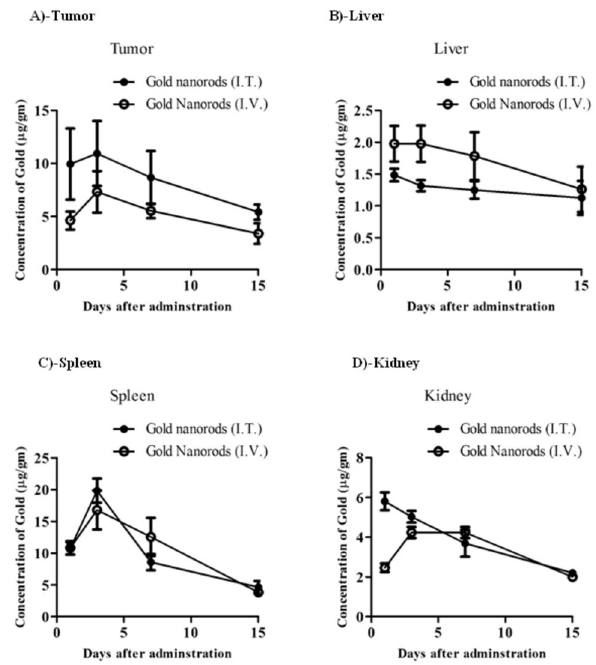
Figure 4. Tissue pharmacokinetics of GNRs after I.V. and I.T. administration to EACC tumor bearing mice. GNRs were administered by I.V. ( ◌ ) or I.T. (●) injection (1.5 mg/kg) to tumor bearing mice. Tissue concentration of gold in tumor (A), liver (B), spleen (C), and kidney (D) tissues were assayed for Gold conetnt at different time intervals until two weeks. Data